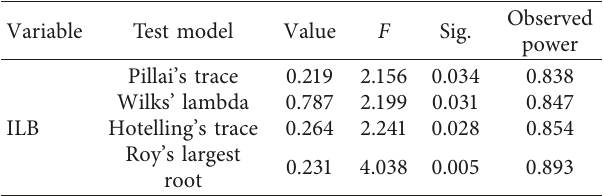
Table 6: Multivariate